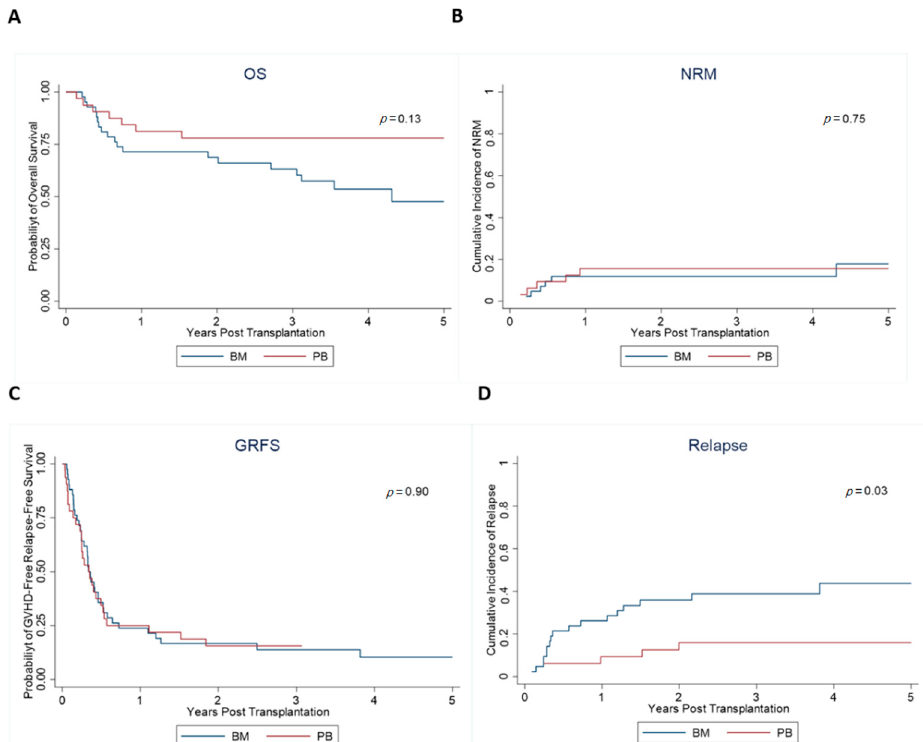
Figure 1: Comparison of survival outcomes between BM and PB grafts. (A) probability of overall survival, (B) non ‐ relapse mortality, (C) GVHD free relapse free survival, and (D) cumulative incidence of relapse.